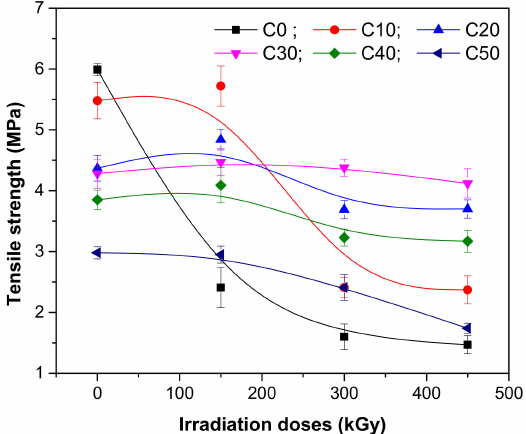
Figure 2. Tensile strength variation as a function of EB irradiation dose and PS amount.